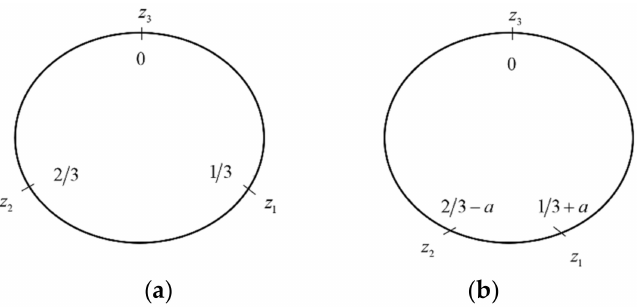
Figure 1. Locations of three firms in the product space. ( a ) Premerger/incompatibility; ( b ) merger/